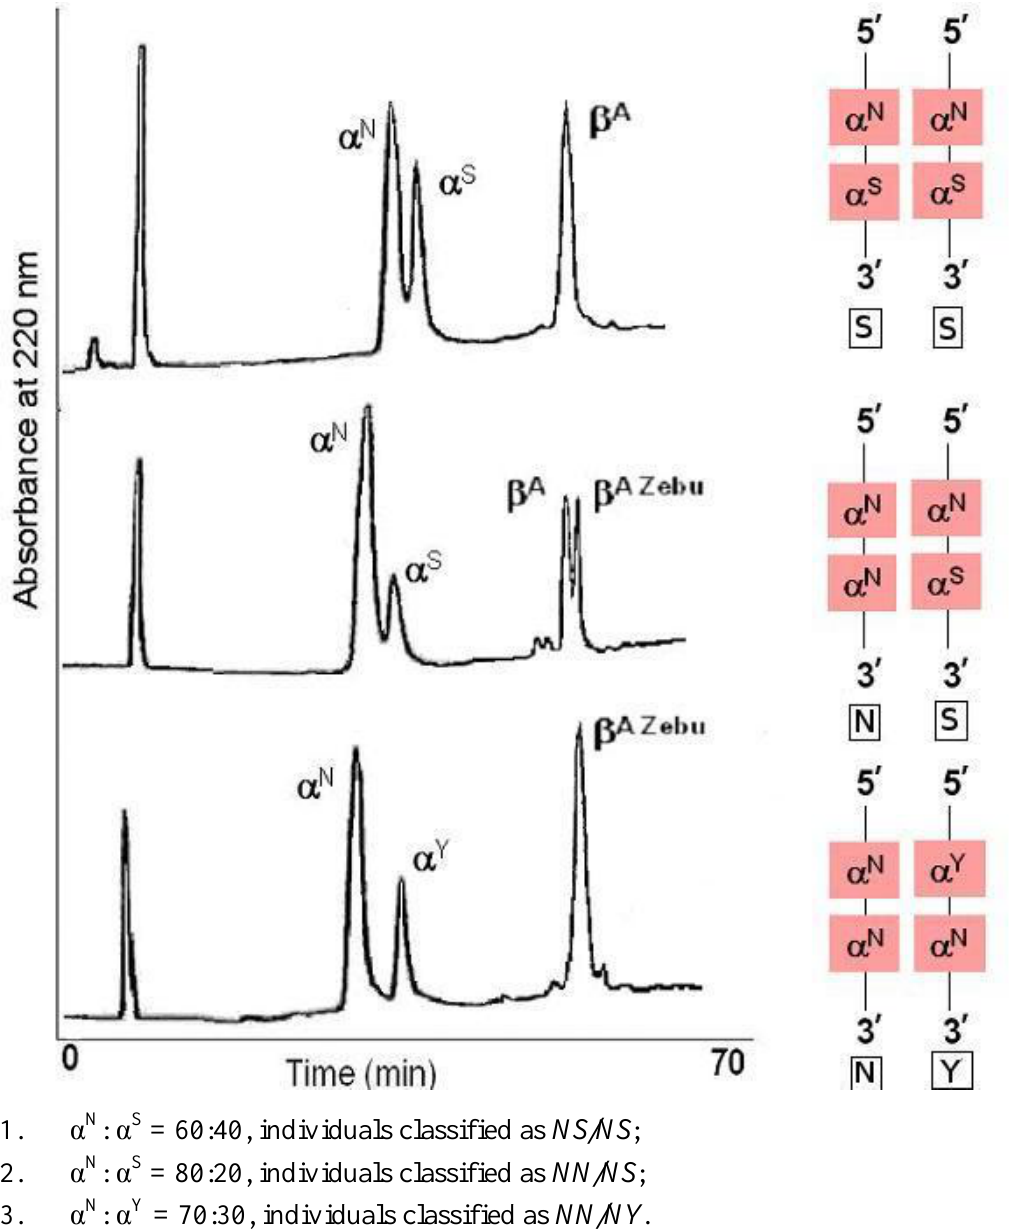
Figure 4. RP-HPLC of alpha and beta globin variants in Podolic cattle. Based on their hydrophobic character, the alpha chains are less hydrophobic than the beta chains and elute with the following sequence: α N , α S , α Y ; the beta chains elute later than the alpha chains and β AZebu is the most hydrophobic globin. The alpha genotype can be inferred from the relative peak